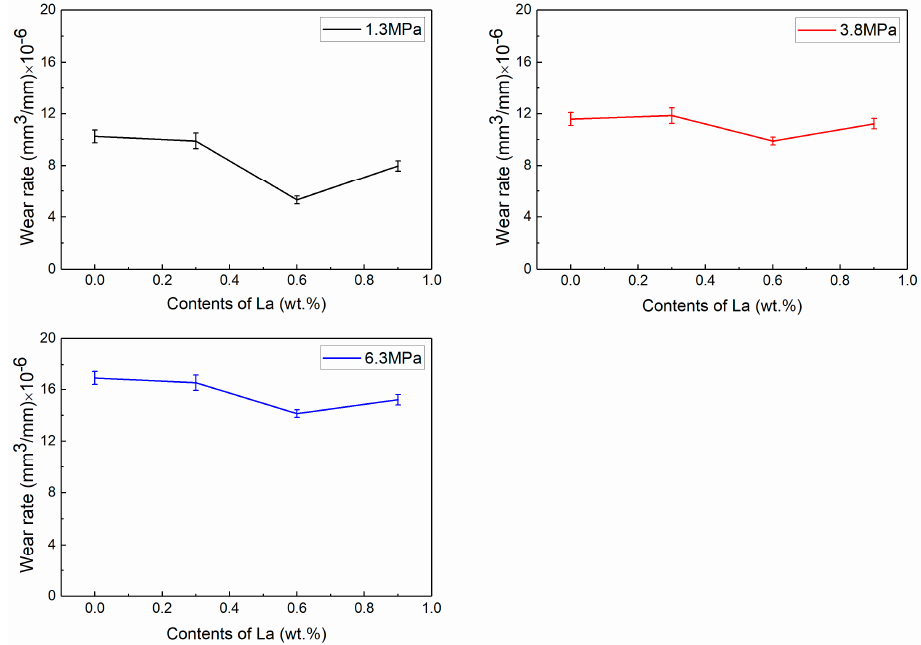
Figure 6. Wear rates variation under the normal loads of 1.3, 3.8, 6.3 MPa, and at a sliding velocity of 0.19 m/s versus the contents of La.